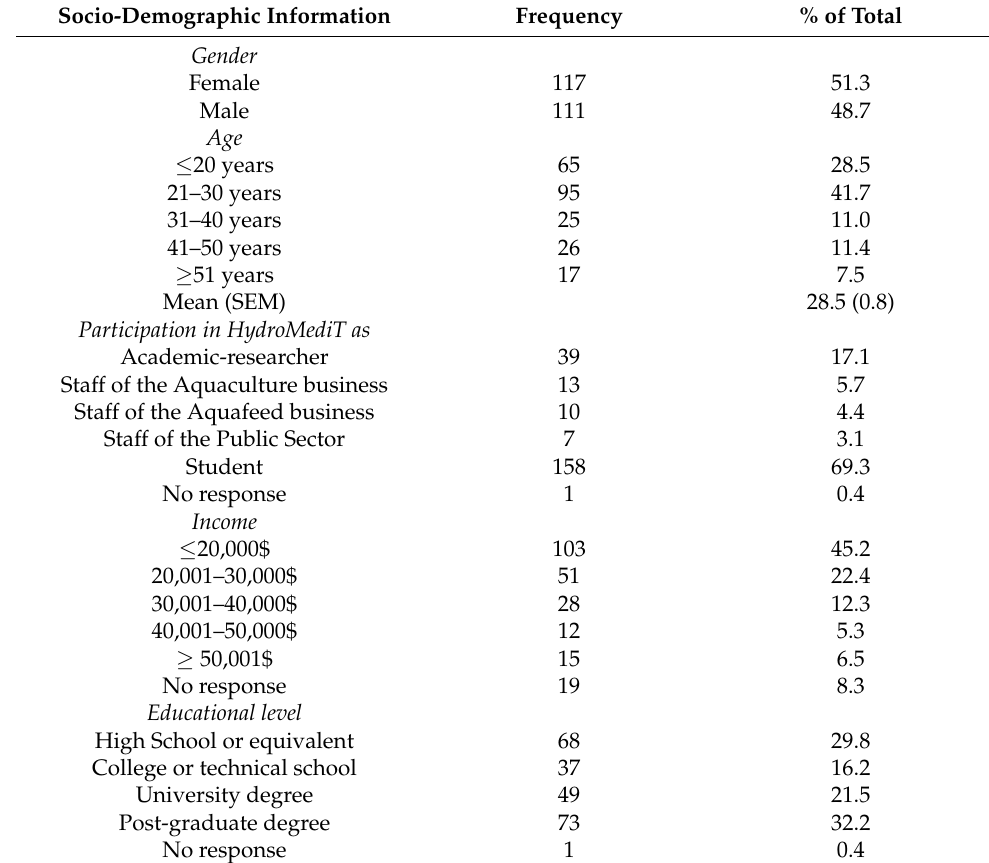
Table 1. Socio-demographic characteristics of the sample (n =